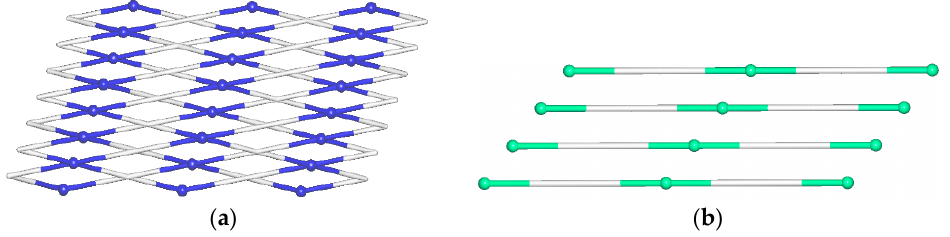
Figure 2. Topological representations of simplified 3D ( a ) and 1D ( b ) metal-organic networks in 1 and 2 ; views along the b axis. The ( a ) mononodal 4-connected net in 1 with a cds topology; 4-connected Co nodes (blue balls), and centroids of 4-connected µ 4 -L 2 − linkers (gray); and ( b ) four linear chains showing a 2-linked net in 2 with a 2C1 topology; Ni nodes (green balls), and centroids of µ -L 2 − linkers (gray).